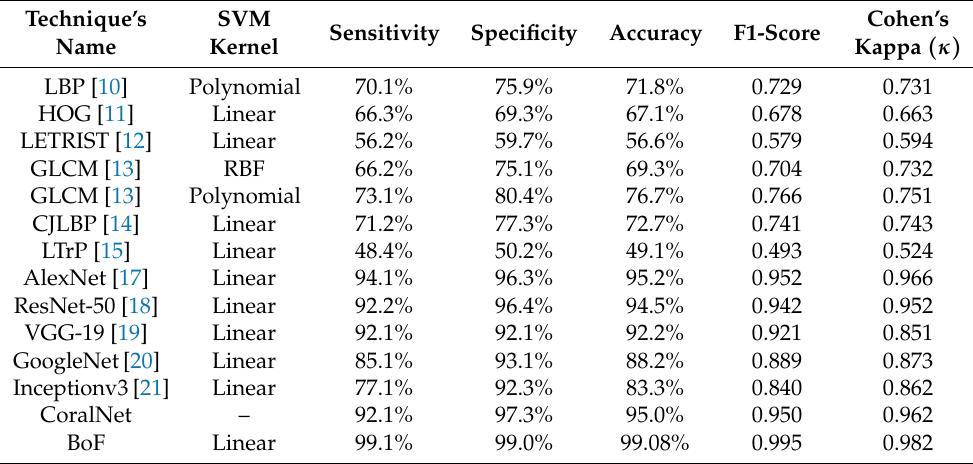
Table 2. Performance of hand-crafted descriptors and D-CNN models for first dataset.